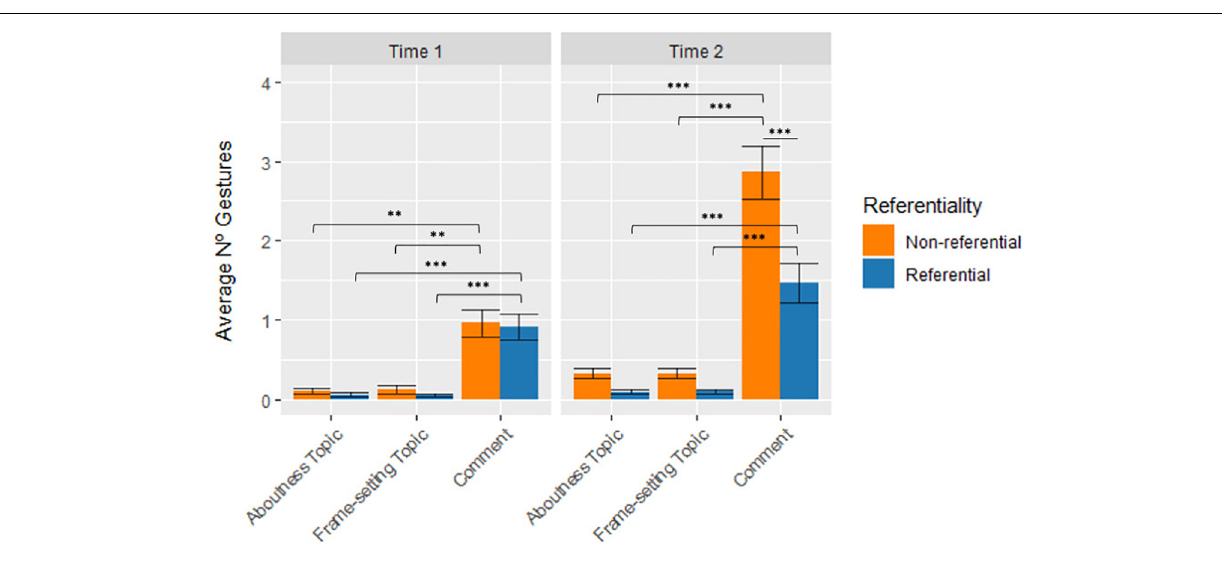
FIGURE 8 | Average number of gestures per child across Time, Gesture Referentiality, and Topic/Comment. Error bars represent standard error. ∗ stands for p ≤ 0.05; ∗∗ stands for p ≤ 0.01; and ∗∗∗ stands for p ≤